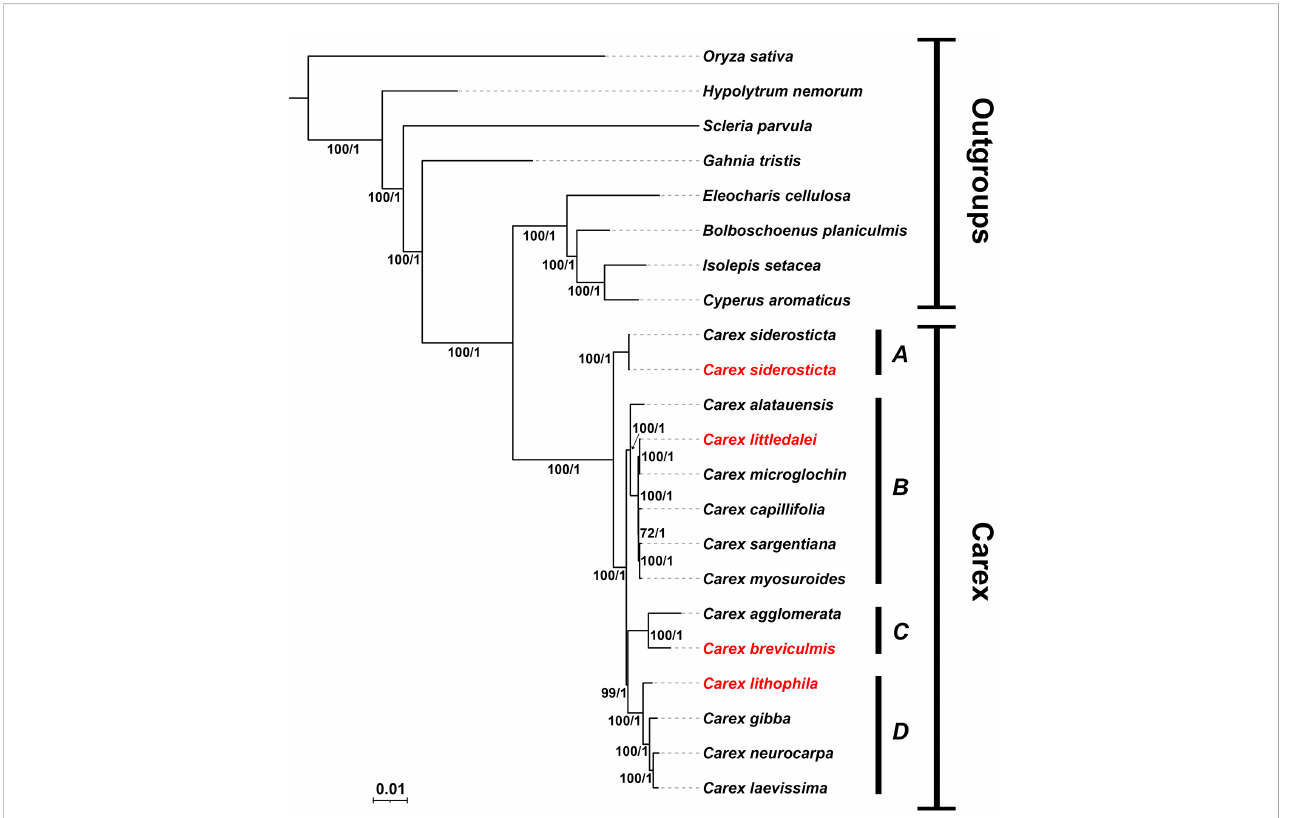
FIGURE 7 Bayesian consensus tree of Carex species based on PCGs. Bootstrap values of maximum likelihood (ML) and predictive probability values (PP) are given at each branches. Chloroplast genomes assembled in this study are highlighted in red. (A) C subg. Siderosticta ; (B) C subg. Euthyceras ; (C) C subg. Carex ; (D) C subg. Vignea